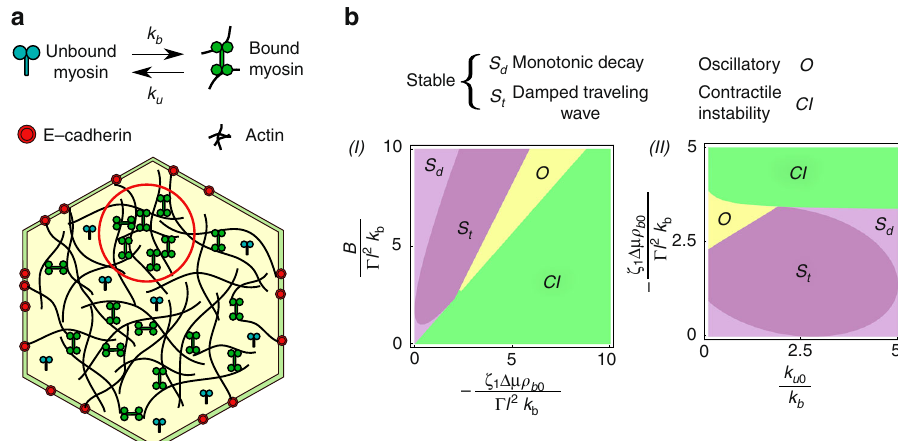
Fig. 1 Schematic of apical cortex and linear stability results: a Schematic showing the medial actomyosin cytoskeletal meshwork within the apical region of a cell belonging to the tissue. The actin fi laments are attached to the cell junctions via E-cadherin (red dots). Myosin mini fi laments bind (unbind) with rates k b ( k u ) and when bound, apply contractile stresses on the actin fi lament meshwork — the red circle demarcates a region of higher mesh compression. Both actin fi laments and myosin mini fi laments undergo turnover. b (I – II) Linear stability phase diagrams in (I) effective elastic stress density vs. contractile stress density at k = 1 and (II) Effective contractile stress density vs. inverse lifetime of bound myosin at B = 4. The stresses are normalized by the frictional stress density, Γ k b l 2 . The phases are described in the legend. Rest of the dimensionless parameters are α = 0.1, c = 0.1, D = 0.1 (see “ Methods ”